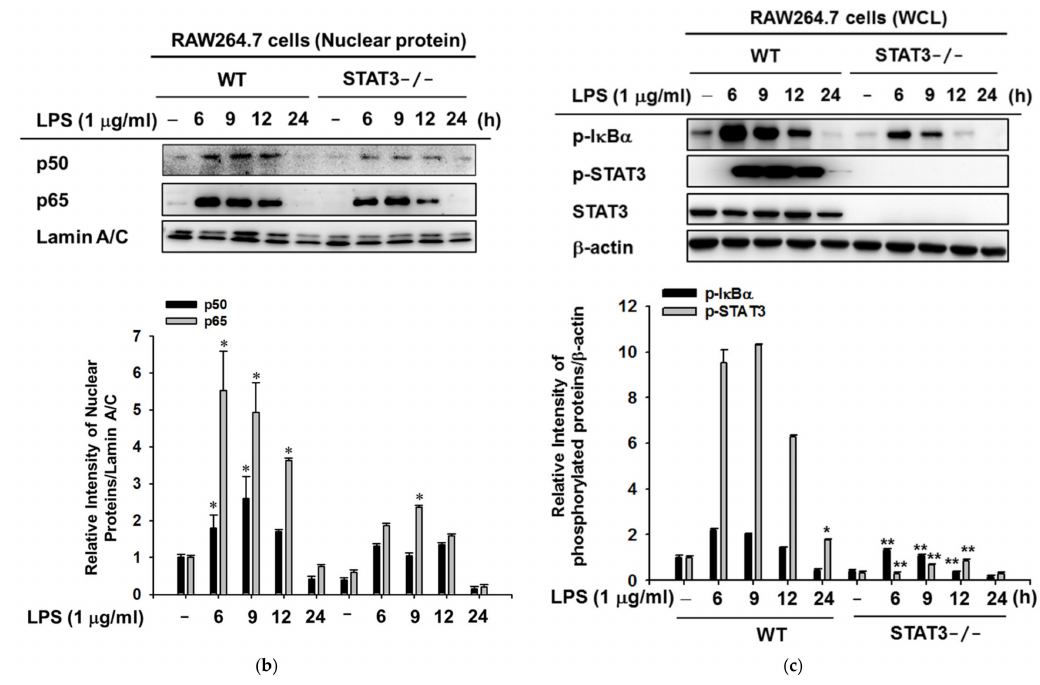
Figure 3. E ff ects of LPS on iNOS gene expression and NF- κ B signaling at later time points. ( a ) mRNA expression of iNOS , TNF- α , IL-6 , COX-2 , IL-10 , IRF-3 , and SOCS3 measured at 6 and 24 h after LPS treatment, in RAW264.7 wild type and STAT3 - / cells - . Values represents average concentrations of the indicated cytokines. Data are presented as the mean ± SD, for replicates of three independent experiments calculated using Student’s t -test (* p < 0.05, ** p < 0.01 as compared with the control (untreated) group). ( b ) Wild type and STAT3 - / - RAW264.7 cells were incubated with LPS (1 µ g / mL for 0–24 h) and nuclear fractions of p50 and p65 were examined by immunoblotting analyses, using lamin A / C as an internal control. ( c ) Wild type and STAT3 - / - RAW264.7 cells were stimulated with 1 µ g / mL LPS for the indicated period and whole cell lysate were then subjected to immunoblotting against I κ B α and STAT3 with β -actin as an internal control. # p < 0.05 and ## p < 0.01 compared to normal